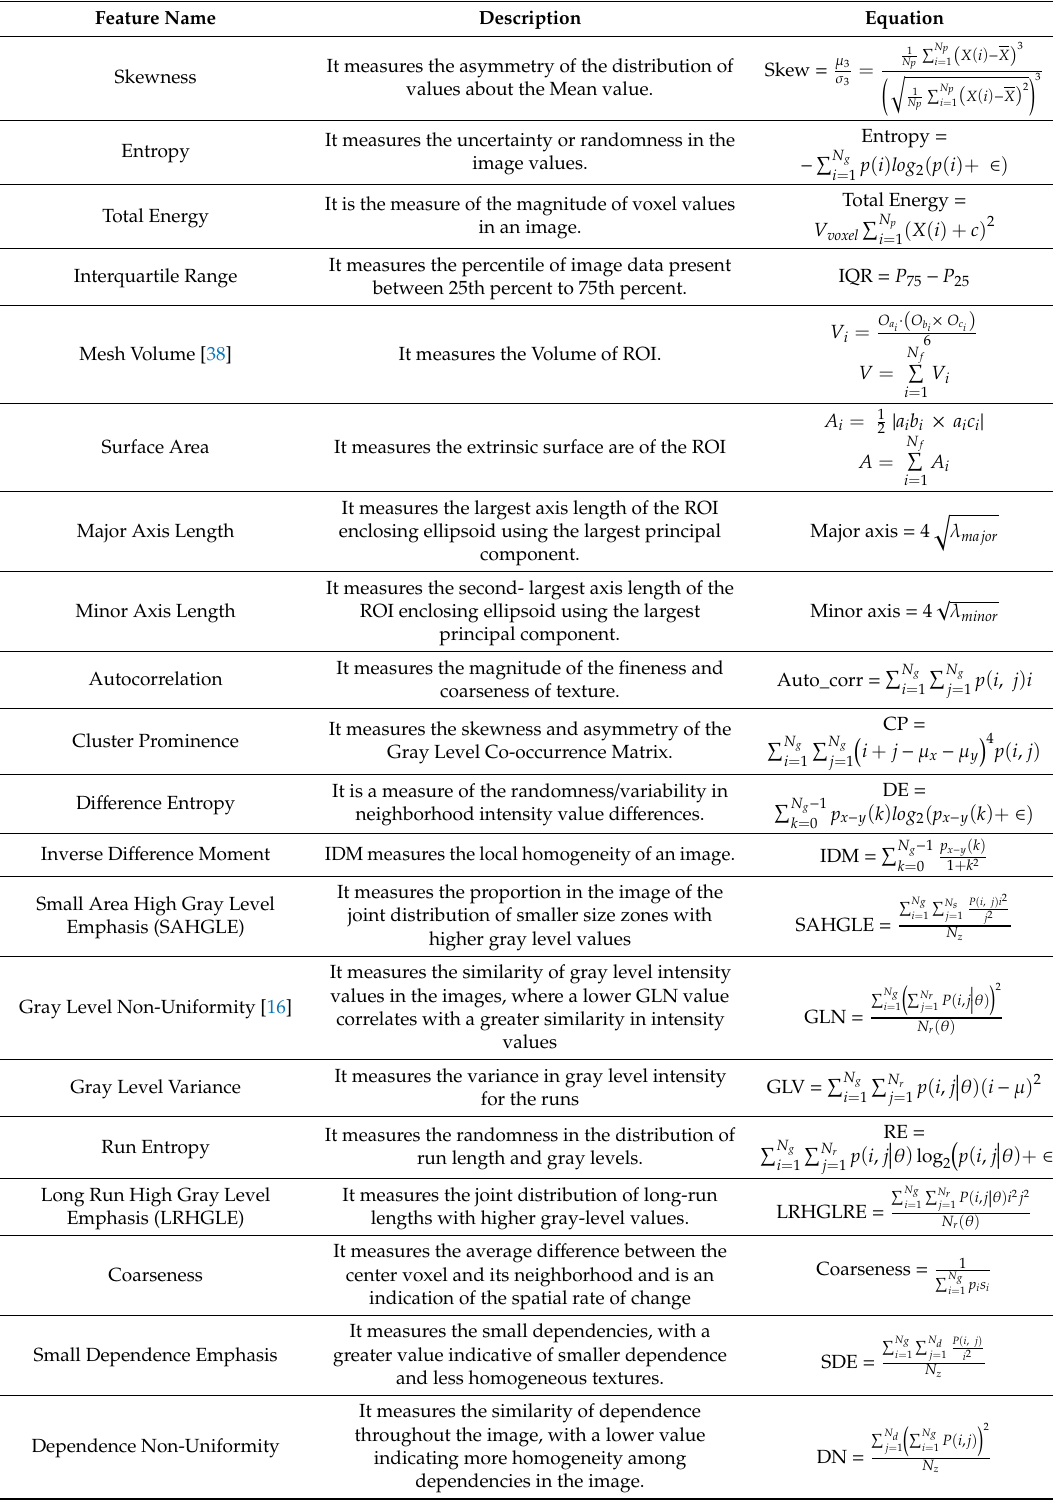
Table 7. Best set of derived features after applying filter methods and recursive feature